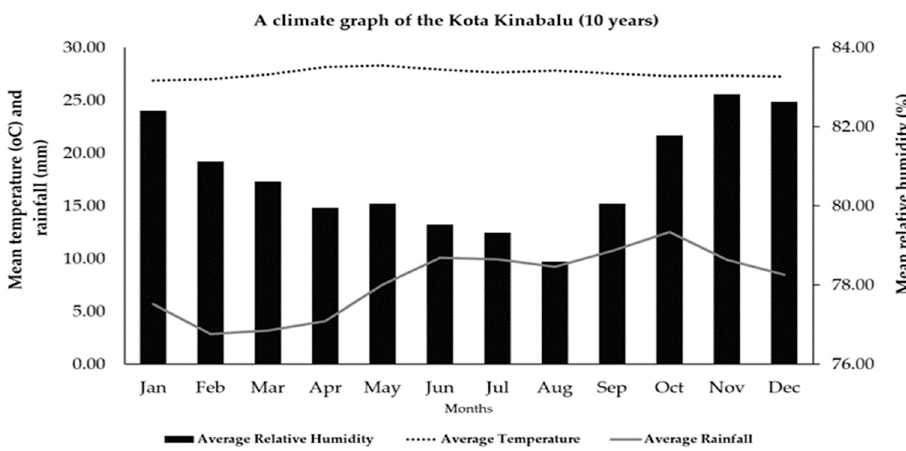
Figure 1. Weather data with the average temperature (°C), rainfall (mm), and humidity (%) over a decade (2012–2022).